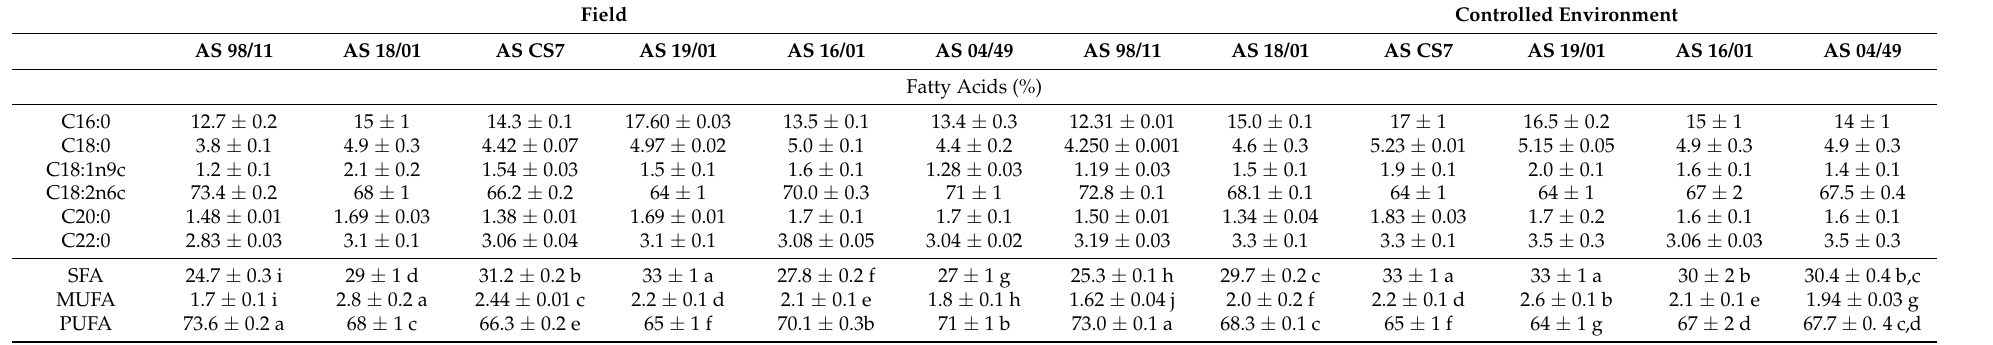
Table 2. Main fatty acids composition of the studied Agaricus subrufescens samples produced in the field and in controlled environment crops.